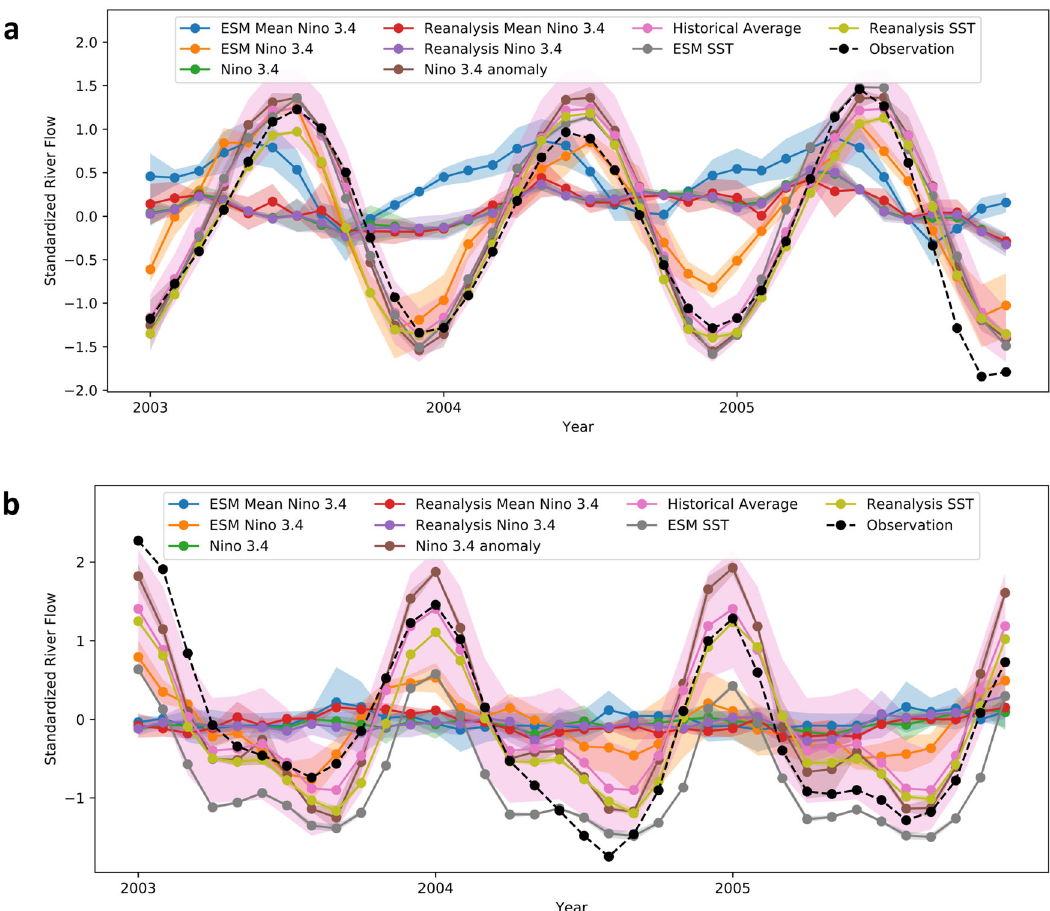
Fig. 2 | Predictions of the interannual variability of the Amazon and Congo rivers based on observed and model-simulated sea surface temperatures compared with climatology. River fl ow ground truth observations (black) and predictions using different predictors from January 2003 to December 2005 for Amazon ( a ) and Congo ( b ) iver. The predictors are mean Niño 3.4 calculated from 32EarthSystemModels(ESM)(ESMMeanNiño3.4),Niño3.4calculatedfromeach of 32 ESMs (ESM Niño 3.4), Niño 3.4 index from NOAA (Niño 3.4), Niño 3.4 calcu- latedfrom3reanalysis(ReanalysisMeanNiño3.4),Niño3.4calculatedfromeachof 3 Reanalysis (Reanalysis Niño 3.4), Niño 3.4 anomaly (Niño 3.4 index calculated